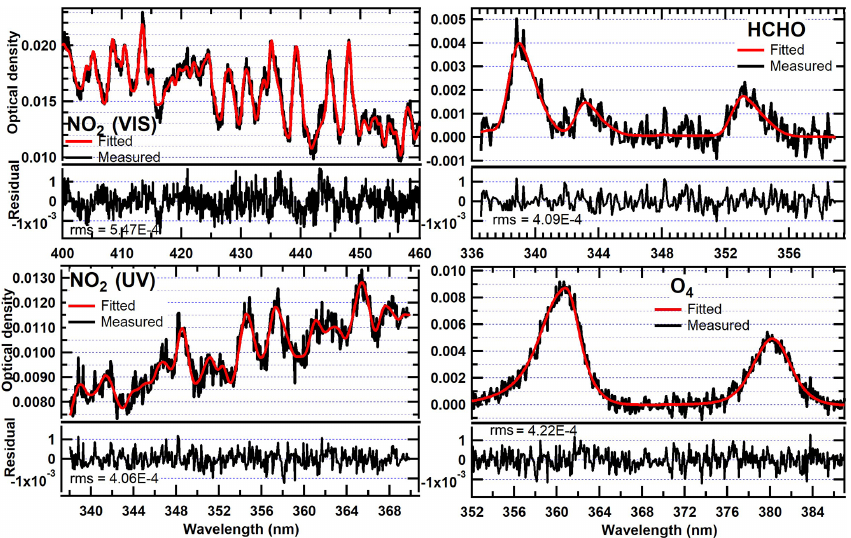
Figure 2. Example DOAS fits and residuals for NO 2 in the visible (dSCD = 2 . 91 × 10 16 ± 2 . 89 × 10 14 molecules cm − 2 ) and UV (dSCD = 2 . 09 × 10 16 ± 8 . 17 × 10 14 molecules cm − 2 ), HCHO (dSCD = 7 . 23 × 10 16 ± 4 . 32 × 10 15 molecules cm − 2 ), and O 4 (dSCD = 2 . 06 × 10 43 ± 4 . 25 × 10 41 molecules 2 cm − 5 ) for a typical spectrum measured on 26 July 2015 at a solar zenith angle of 20 ◦ and 2 ◦ elevation